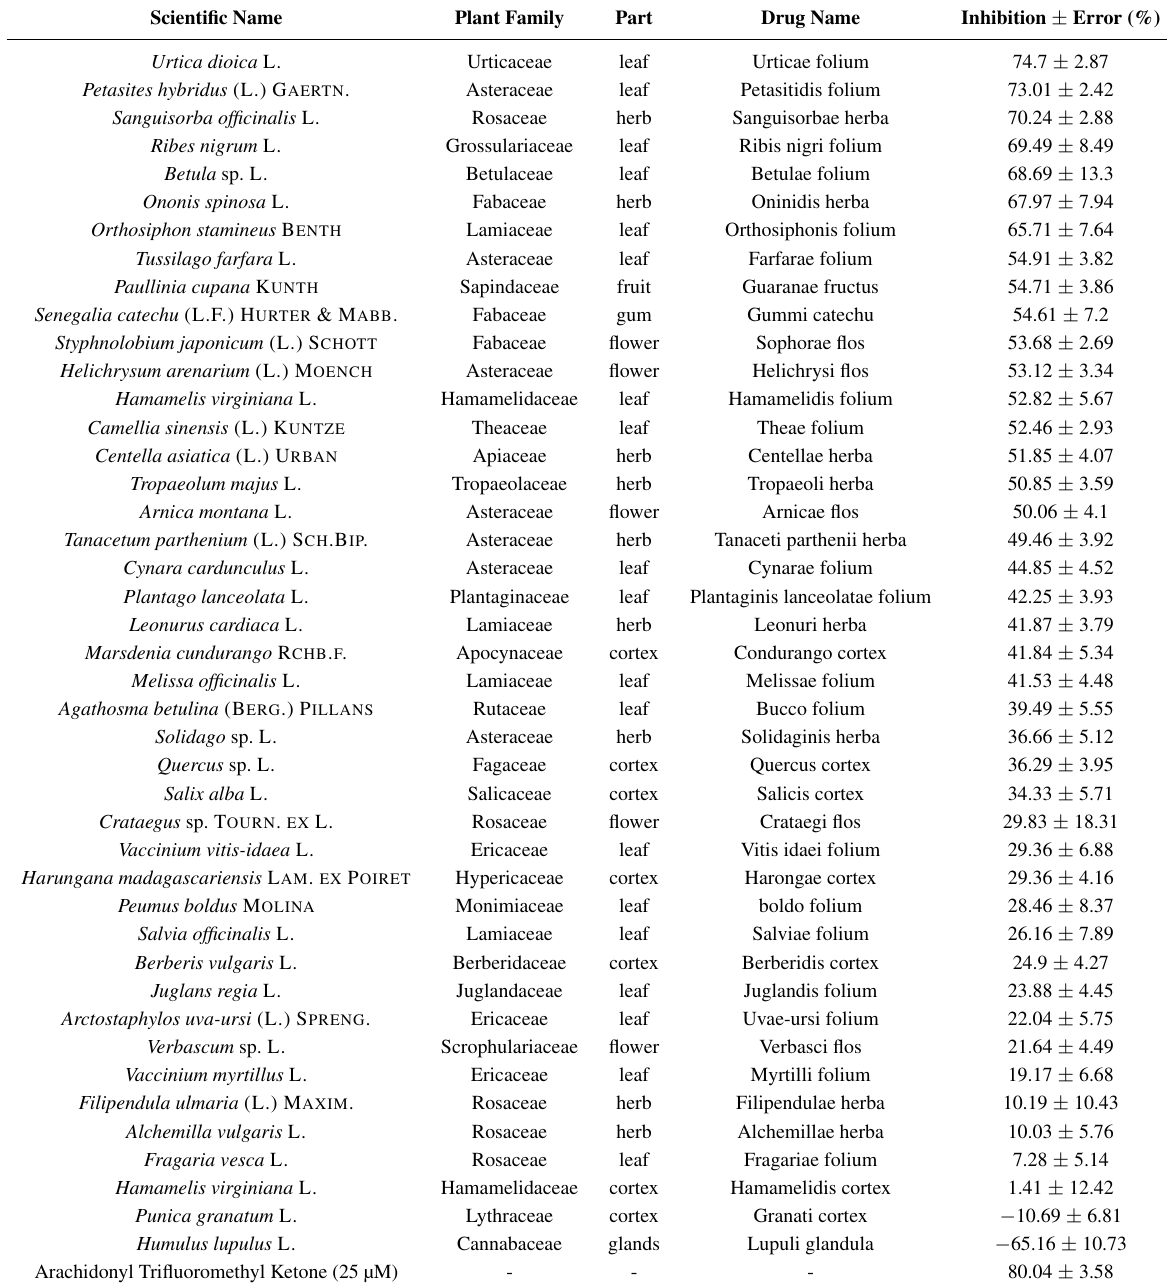
α inhibition (%) by 100 µg/mL methanol extract of 43 plants. Species are Table 1. cPLA 2 ordered according to their inhibitory